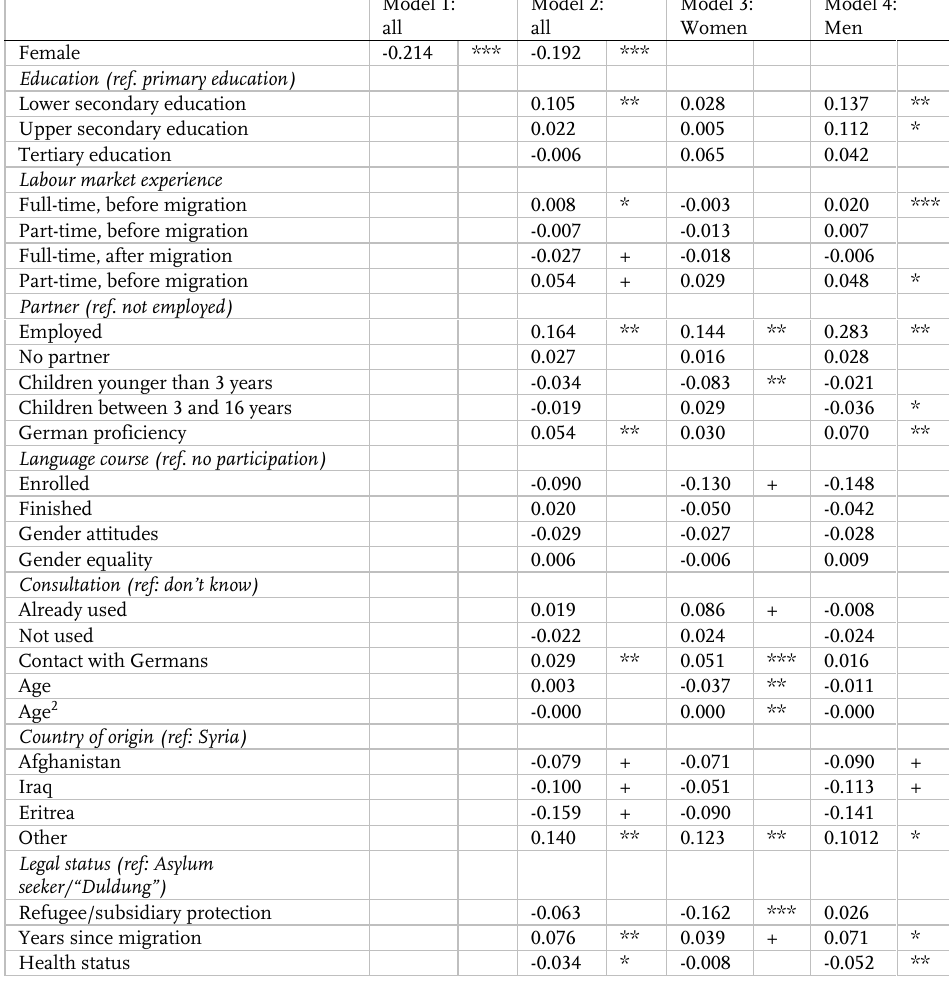
Table A.4 : Results from logistic regression (1: Employed; 0: Not employed), pooled models and models by gender, average marginal effects (AME) Model 1: